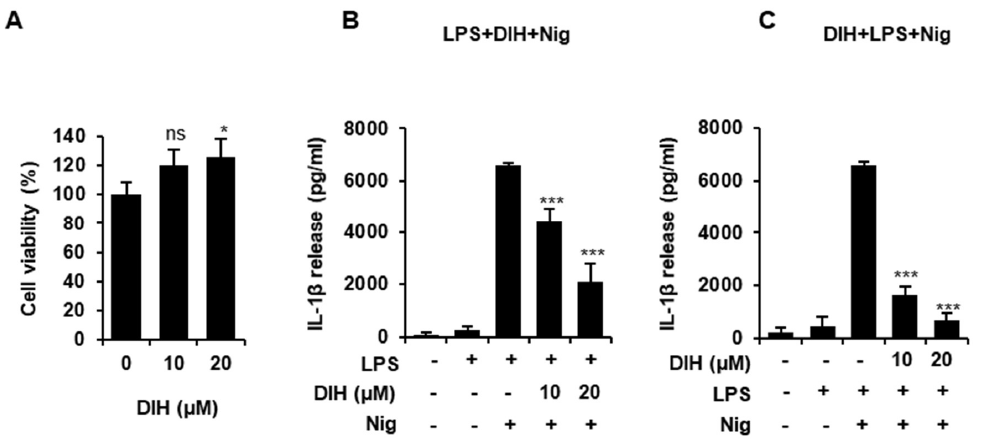
Figure 7. DIH reduces NLRP3 inflammasome activation in BMDMs ( A ) BMDMs viability after treatment with DIH (10, 20 μM) for 24 h was determined by MTT assay and results are reported as mean ± SD (n = 3). ns = not significant and * p < 0.05 vs. untreated cells. ( B ) BMDMs were primed for 4 h with LPS (1 μg/mL), followed by treatment with DIH (10, 20 μM) for 30 min and then Nig (20 μM) for 1 h. ( C ) BMDMs were preincubated with DIH (10, 20 μM) for 30 min, then stimulated with LPS (1 μg/mL, 3 h) and then with Nig (20 μM) for 1 h. Levels of IL-1β in the culture medium were measured using ELISA. Results show the means ± SD of three independent experiments. *** p < 0.001 vs. LPS + Nig treatment.